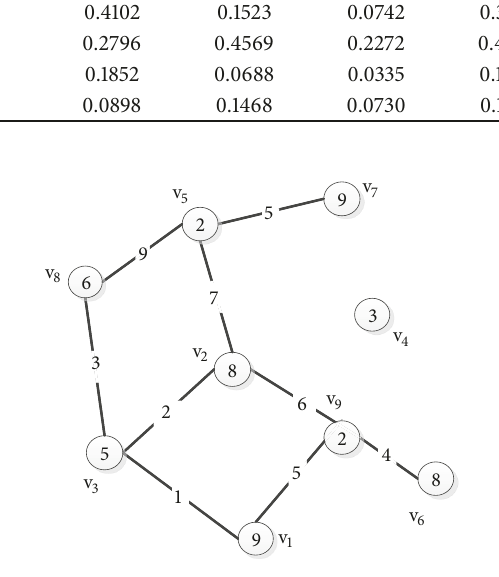
Figure 5: Comparison of the integratedpower and Banzhaf